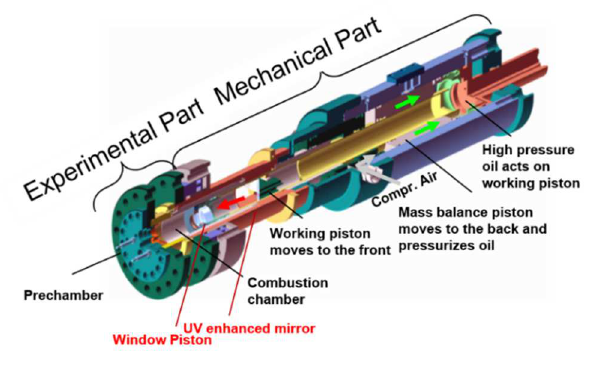
Fig. 1. Schematic of the RCEM, adapted from [15] Table 1. Technical characteristics of the Rapid Compression Expansion